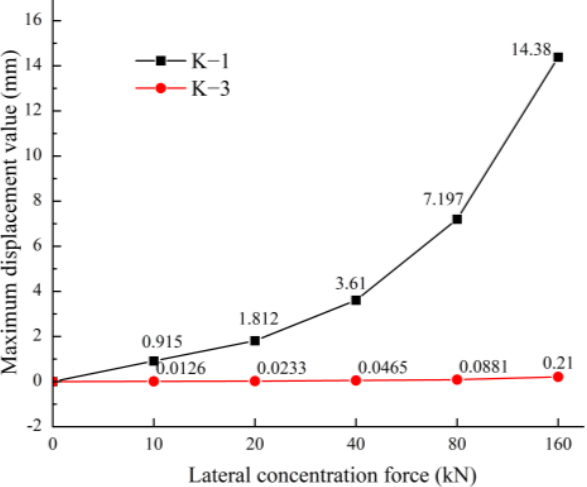
Figure 9. Comparison of the maximum displacement value of the structure.